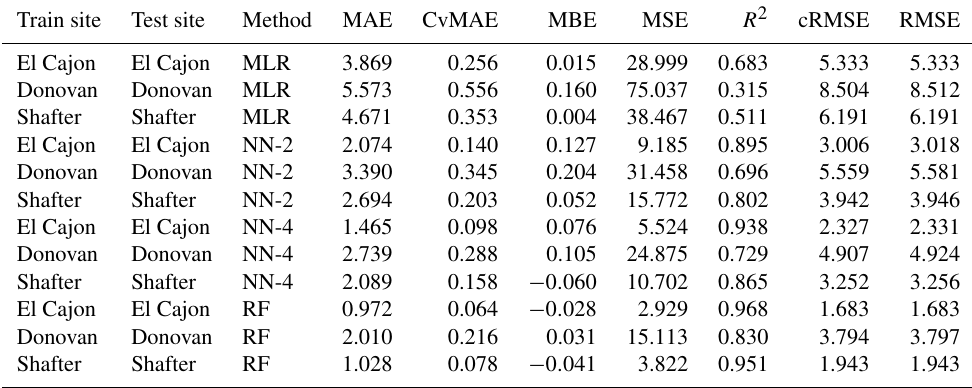
Table C2. Level 0 test results for NO 2